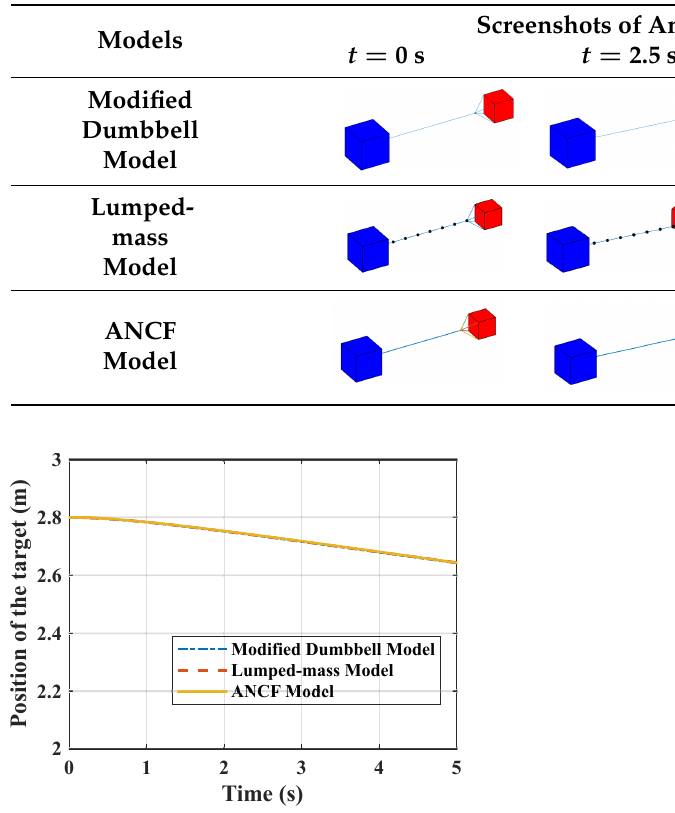
Figure 13. Position of the mass center of the target.